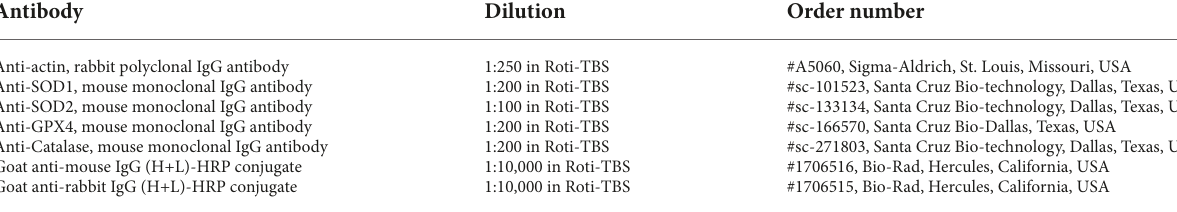
TABLE 2 Primary and secondary antibodies used for Western blotting. Antibody Dilution Order number Anti-actin, rabbit polyclonal IgG